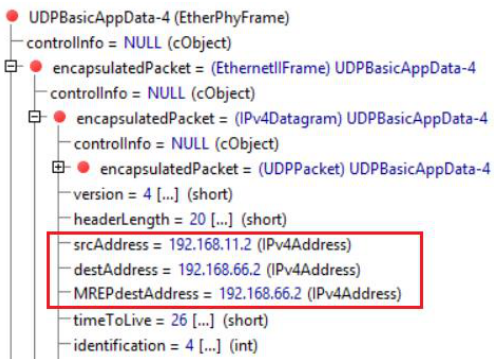
Figure 16. Restoration of EM-REP packet to original destination address.